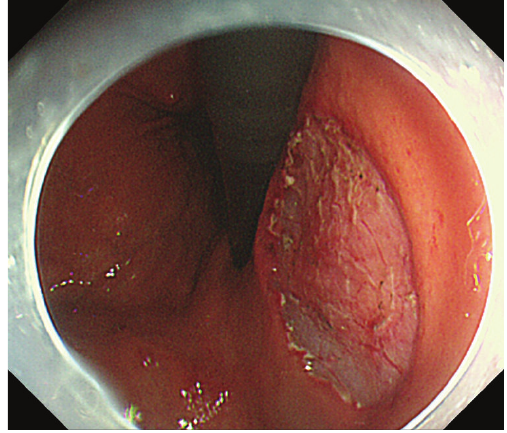
Figure 4: Post-ESD image of the lesion of Figure 2. There is no carbide on ESD ulcer.